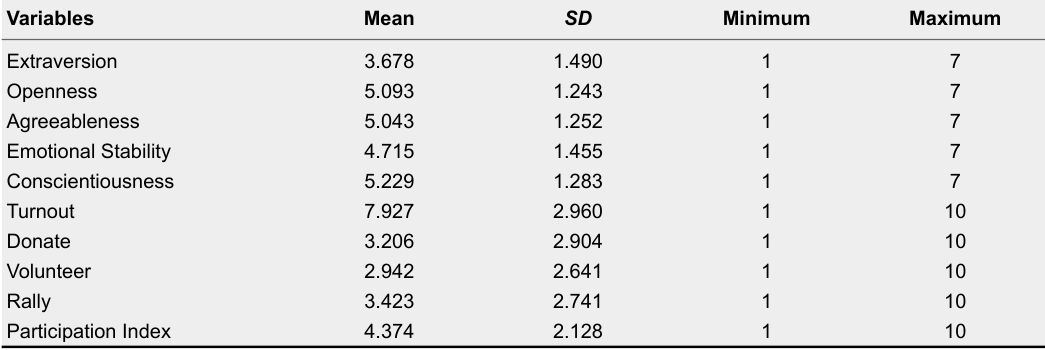
Descriptive Statistics for Personality and Participation Measures (N = 724)